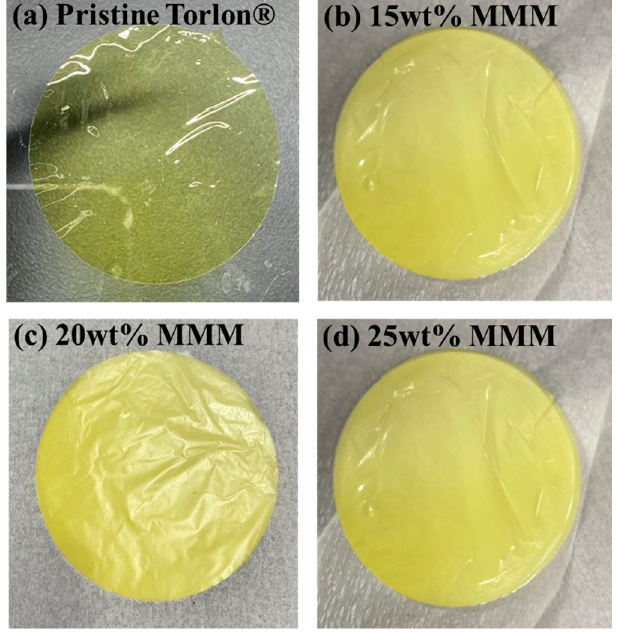
Figure 5. The casted membrane with a doctor blade: ( a ) Image of pristine Torlon ® membrane; ( b ) 15 wt% L-His-ZIF-8/Torlon ® MMM; ( c ) 20 wt% L-His-ZIF-8/Torlon ® MMM; ( d ) 25 wt% L-His-ZIF-8/Torlon ® MMM .